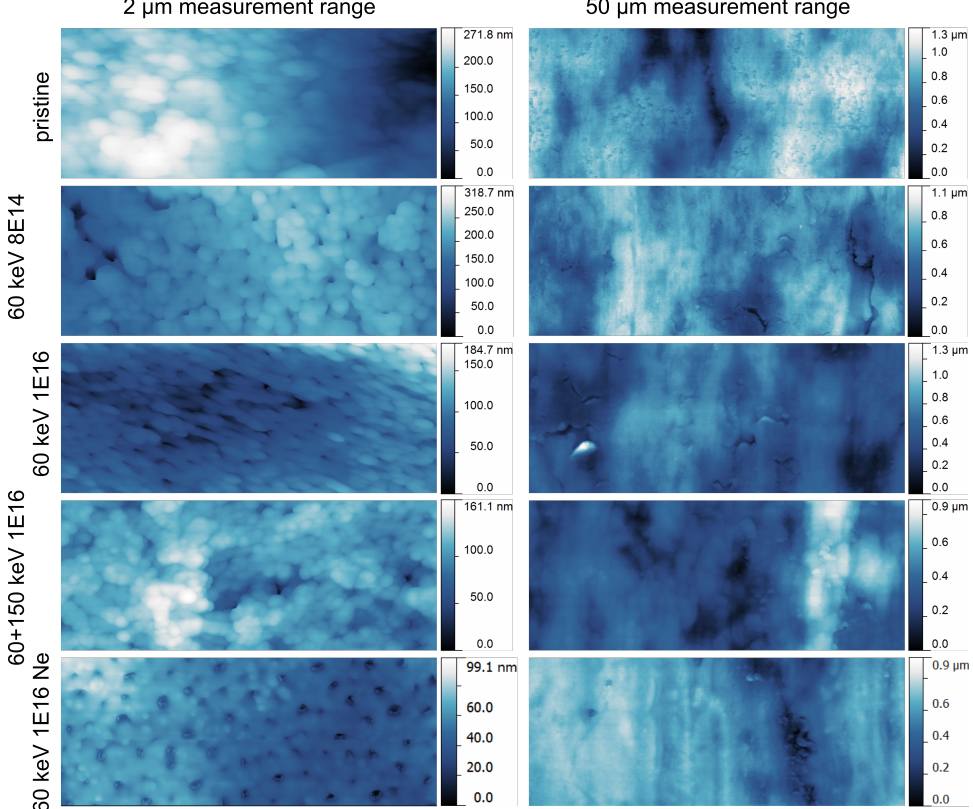
Figure 4. AFM images of NT arrays before and after ion bombardment. In the left column, the to- pography is measured on a 2 µ m range; all images are 1 µ m wide. The NT arrays are observed as small, circular cavities (dark blue to black). In the right column, the measurement range was enlarged to 50 µ m, and the width of the images amounts to 25 µ m. The rolling pattern, originating from the production process of the Ti foil, runs